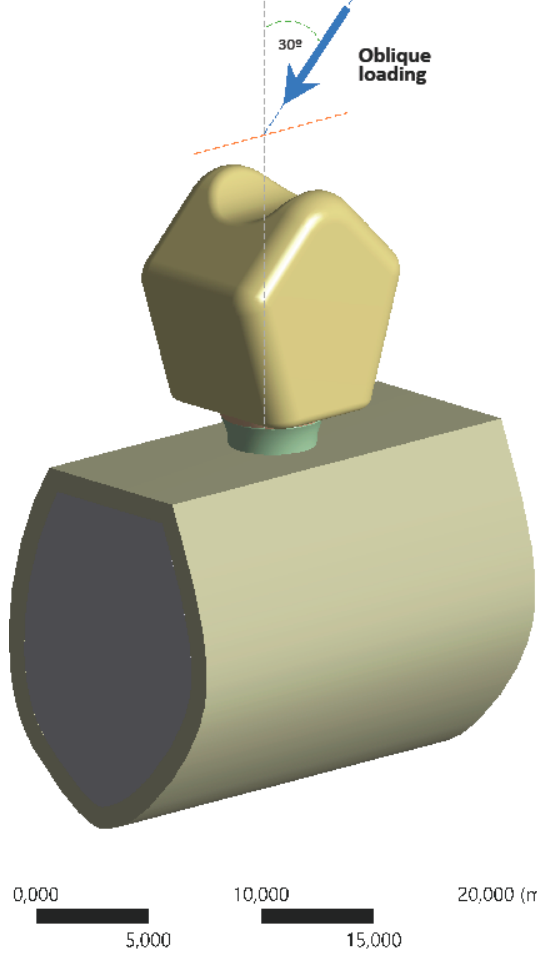
Figure 2. Boundary and load conditions of the FE model. Total force applied of 150 N. FE, finite element.